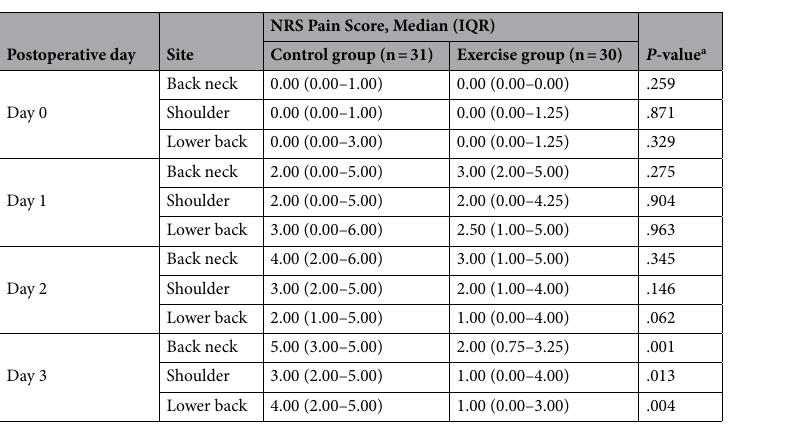
Table 2. Musculoskeletal pain scores of the study groups. NRS, numeric rating scale; IQR, interquartile range. a Bonferroni-corrected P values were obtained using the Mann–Whitney